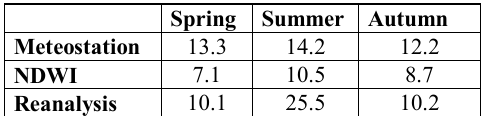
Table 3. Standard deviation values of the growing